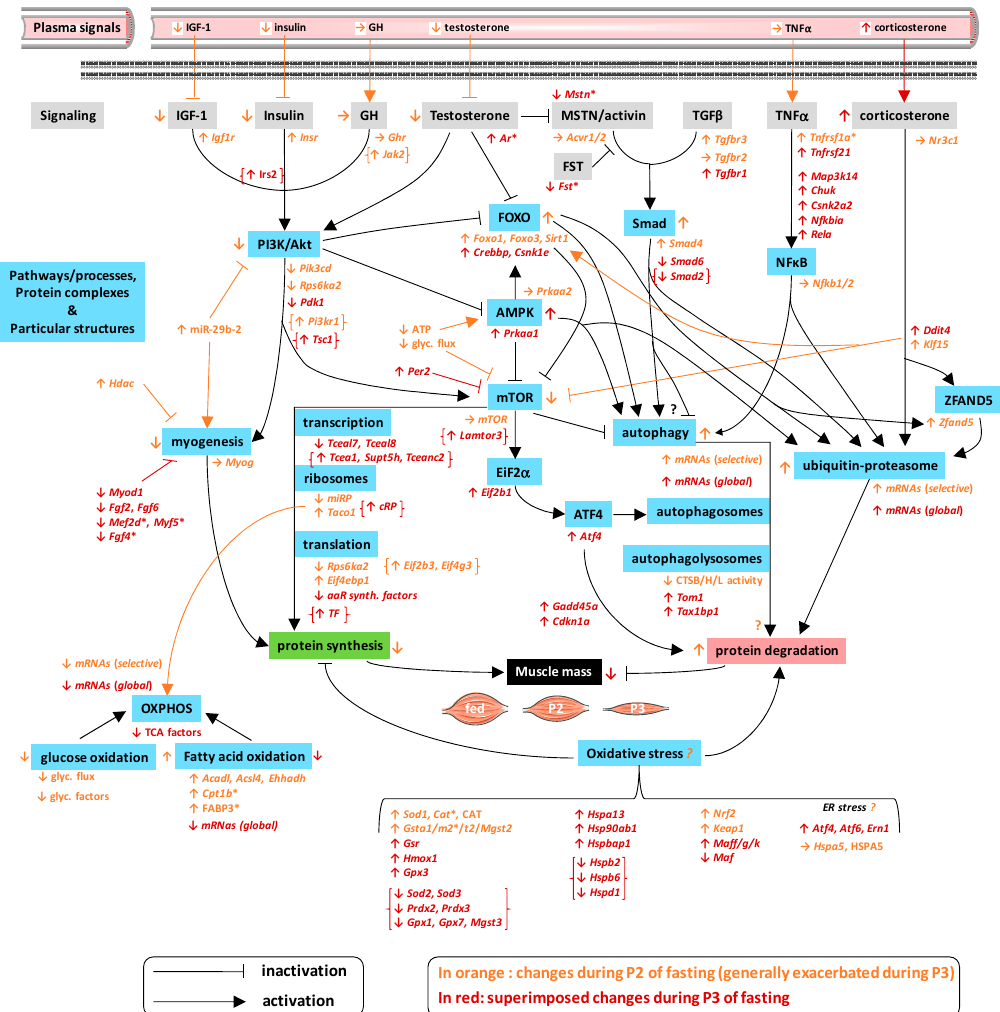
Figure 7. Molecular regulations controlling muscle mass during prolonged fasting in rats. This figure summarizes the molecular changes we observed in rat skeletal muscle during P2 and P3 of prolonged fasting compared to fed state. Significant changes in mRNA (ANOVA and Tukey p -values < 0.001) and protein abundances (ANOVA and Tukey p -values < 0.05) are shown in italic and capital letters, respectively. Non-significant changes but exhibiting a clear trend are highlighted with a “*”. The vast majority of muscle regulations were in line with downregulation of protein synthesis and upregulation of protein degradation during P2 and more markedly P3 of fasting. Opposite regulations are shown between braces. Glyc. flux: glycolytic flux; aaR synth.: aminoacyl-transfer ribonucleic acid (tRNA) synthesis; miRP: mitochondrial ribosomal proteins; cRP: cytosolic ribosomal proteins; TF: translation factors.